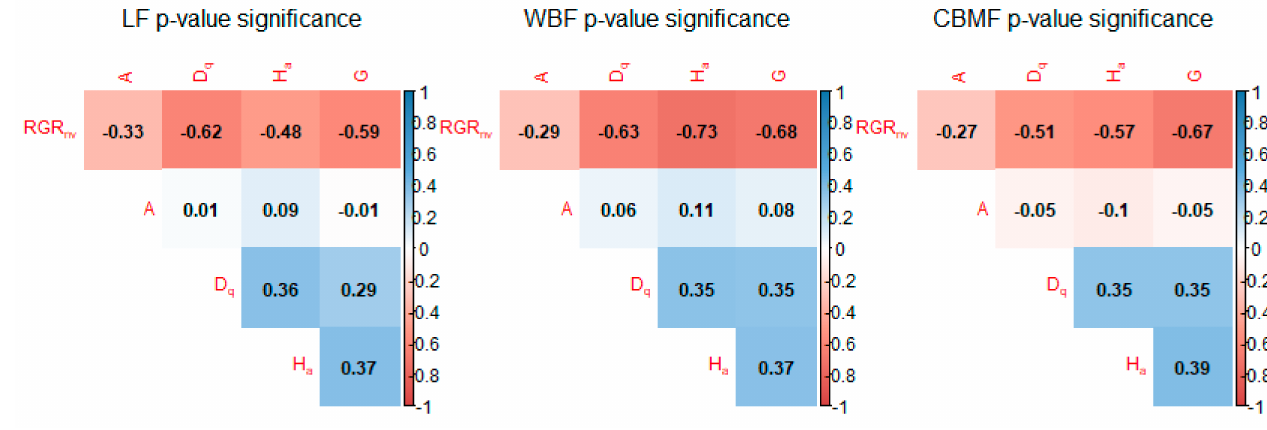
Figure 4. Variables correlation test diagram of the three forest